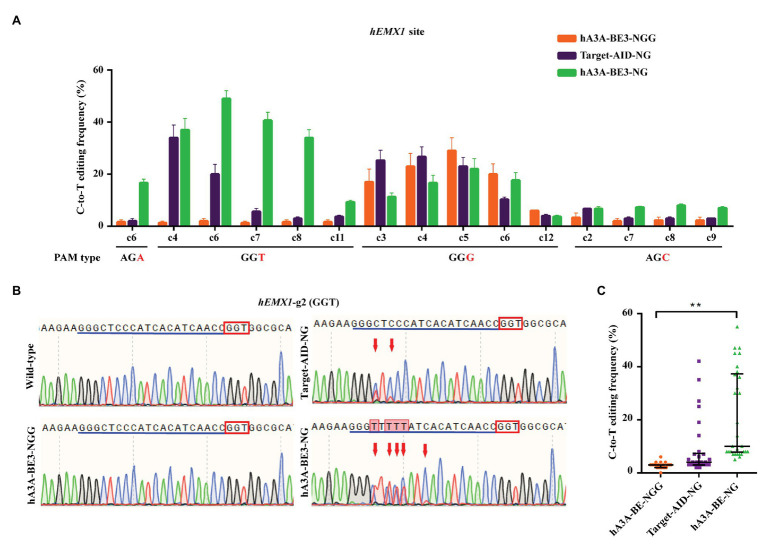
Efficient C-to-T conversion in human HEK293T cells by hA3A-BE3-NG. (A) C-to-T editing by hA3A-BE3, hA3A-BE3-NG, and Target-AID-NG at four endogenous EMX1 gene sites in human HEK293T cells. The target base in the editing window is shown, counting the end distal to the PAM as position 1. Data are represented as the mean ± SEM (n = 3). (B) Sanger sequencing results of HEK293T cells transfected with hA3A-BE3, hA3A-BE3-NG, or Target-AID-NG. Red boxes indicate PAMs and blue lines indicate sgRNA sequences. Red arrows indicate substituted nucleotides. (C) Statistical analysis of the C-to-T editing frequency induced by hA3A-BE3, hA3A-BE3-NG, or Target-AID-NG at NGH PAM sites in (A). The median and interquartile range (IQR) are shown; **
p < 0.01.